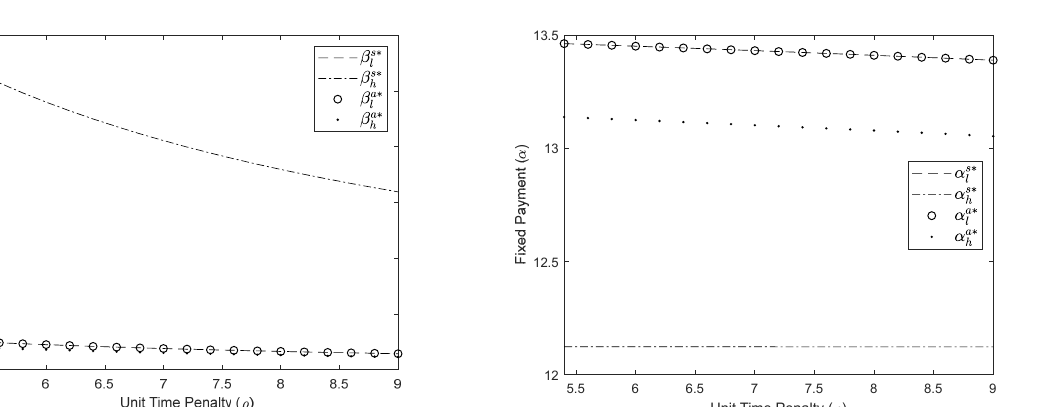
Fig. 8. The fixed payment in the symmetric and asymmetric